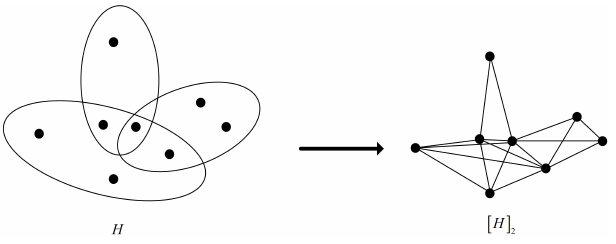
Figure 2. A 2-section of a